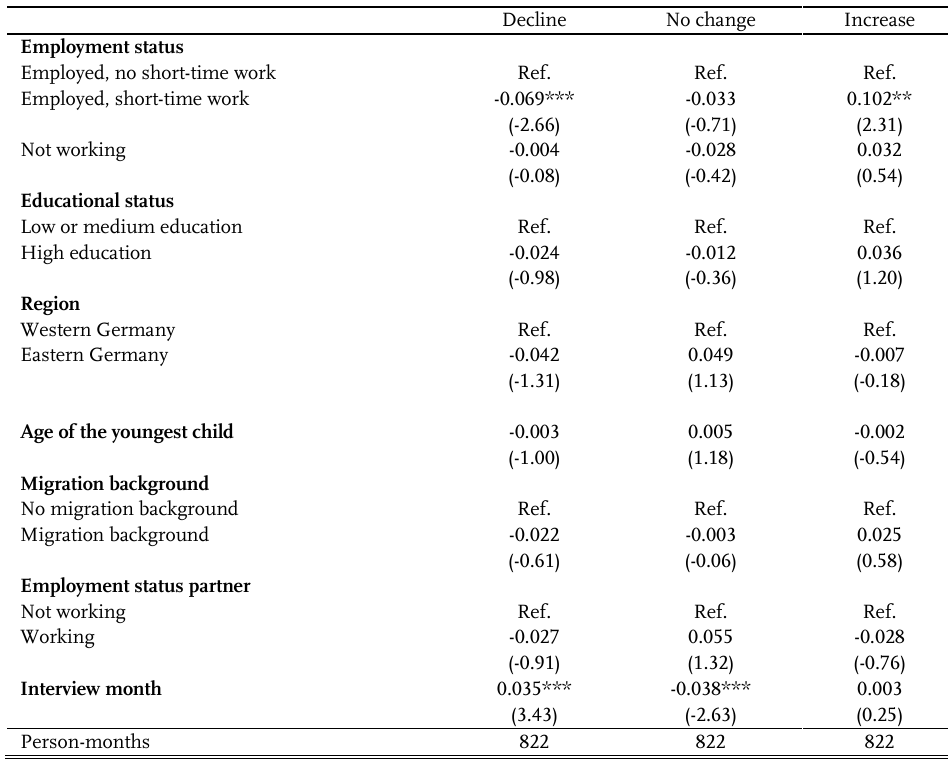
Table A.1 : Regression results. Male sample. Multinomial regression model. Average marginal effects, z- statistic in parenthesis. Dependent variable: Decline in father’s engagement (base outcome), no change, increase in father’s